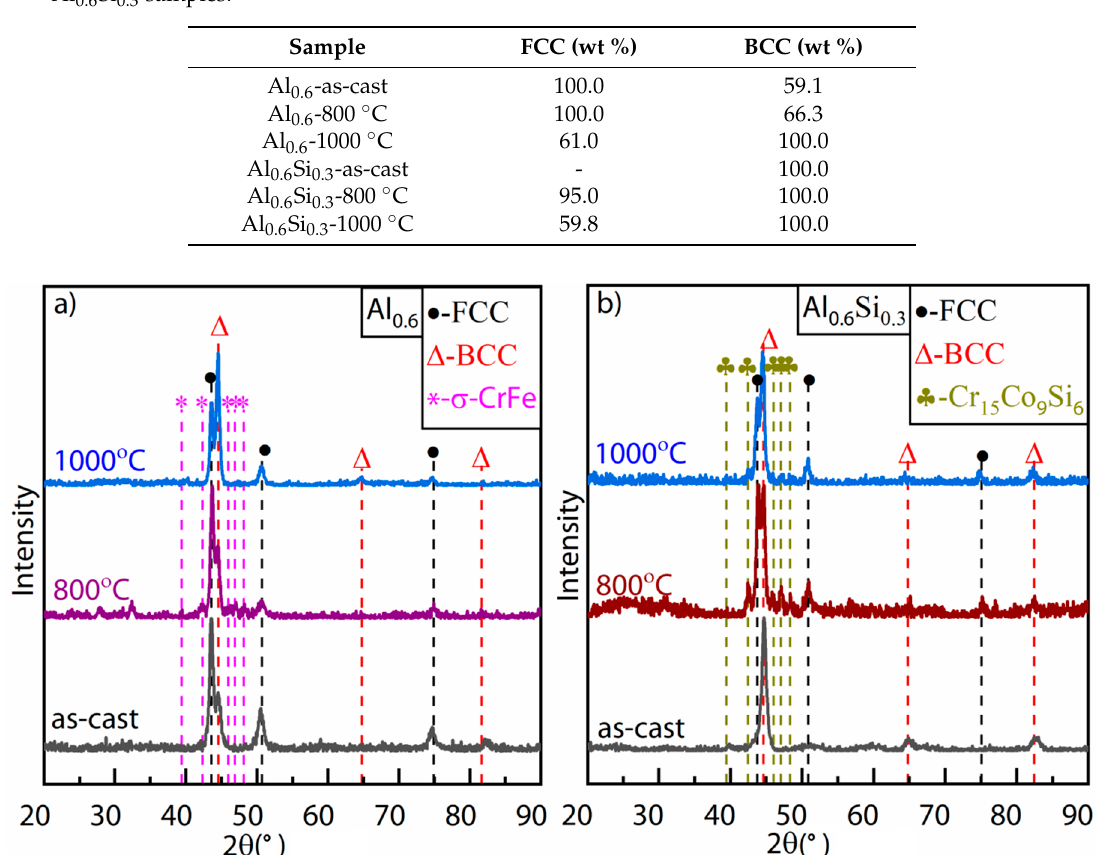
Table 1. Relative phase composition from Rietveld analysis with XRD data for Al 0.6 and Al 0.6 Si 0.3 samples.